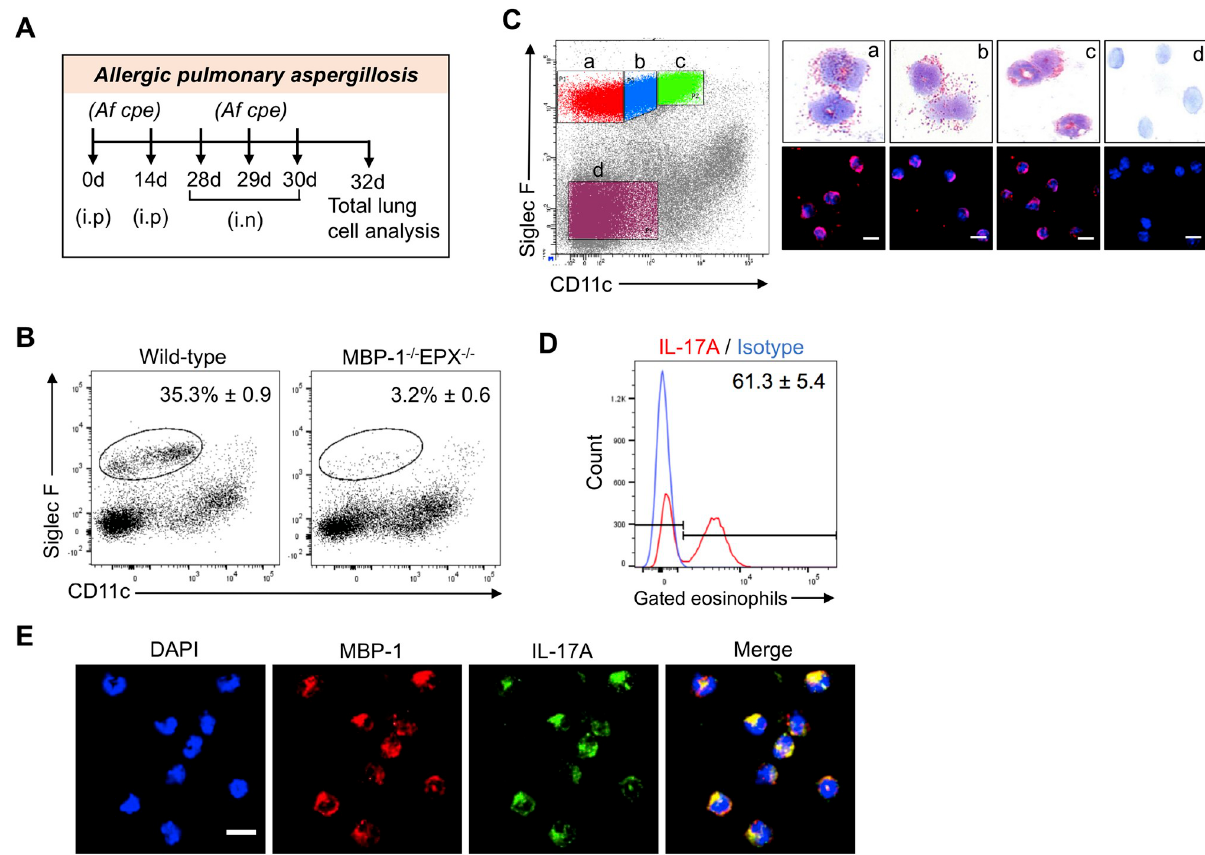
Fig 1. Production of IL-17 by pulmonary eosinophils in mice with allergic aspergillosis. (A) Schematic of allergic pulmonary aspergillosis model . Mice were sensitized intraperitoneally (i.p.) with 250 μ g of A . fumigatus crude protein extract ( Af cpe ) on days 0 and 14. Two weeks later, mice received 3 daily intranasal (i.n.) challenges with 25 μ g of Af cpe . Two days after the 3rd challenge, the mice were euthanized, single cell lung suspensions were prepared, and analyzed for eosinophils and cytokines by flow cytometry with intracellular staining (ICS). (B) Lung eosinophil recruitment .